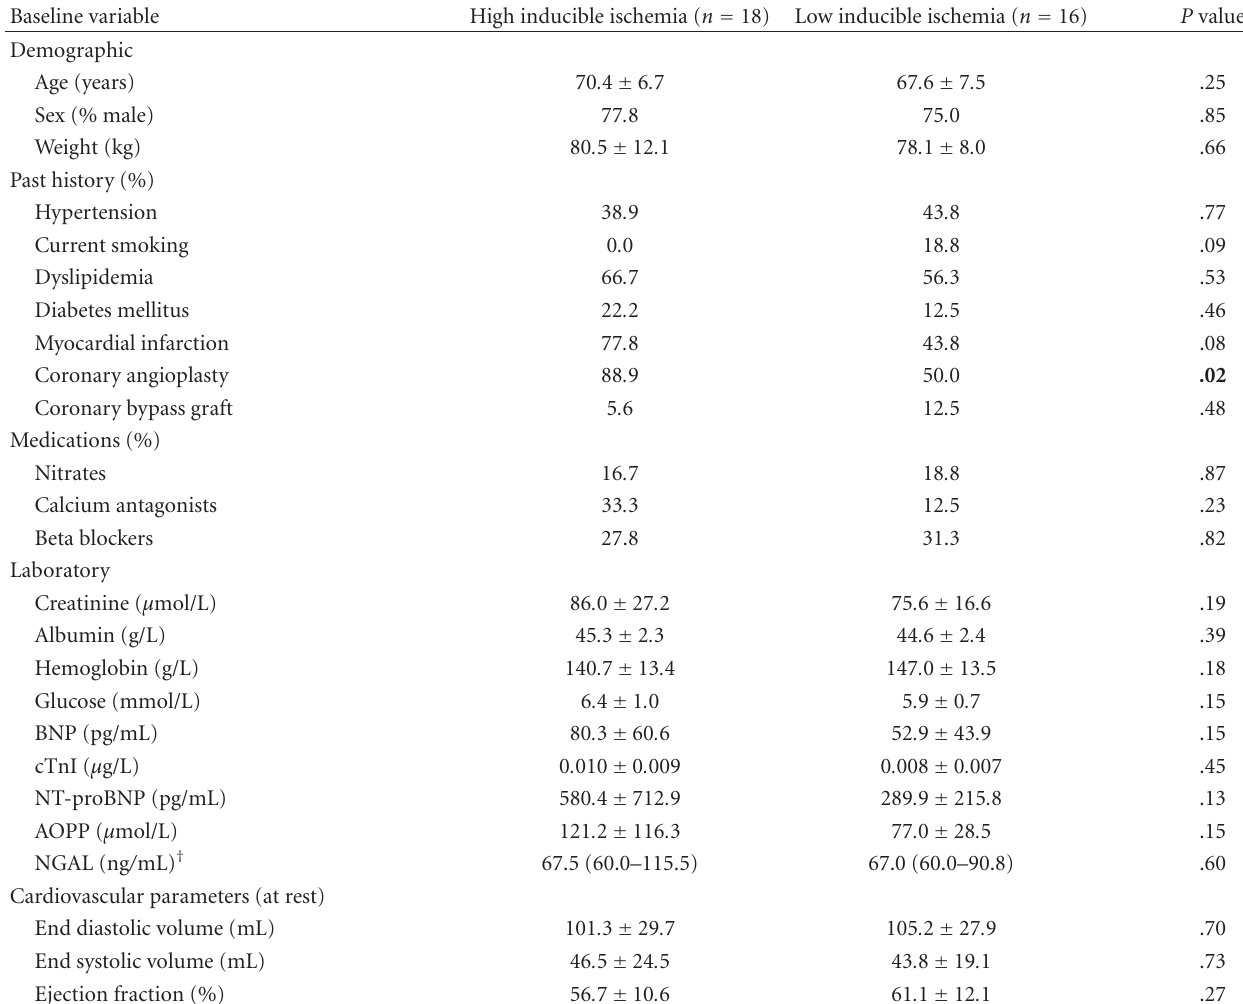
Table 1: Baseline demographic, laboratory, and cardiovascular parameters according to the amount of myocardial ischemia (number of inducible myocardial perfusion